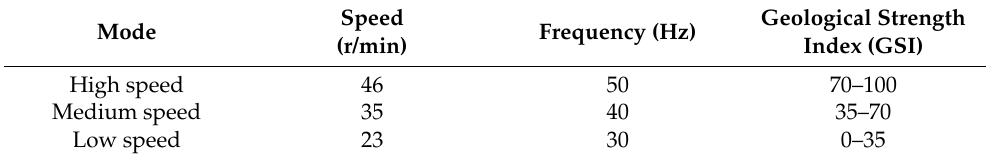
Figure 9. Fractal dimension and path planning. The cutting head swings along the planned path. The cutting head passes through different grids, and the speed of the cutting head is adjusted according to the geological strength index GSI value in the grid. The speed mode of the cutting head of the roadheader is divided into three modes: high speed, medium speed, and low speed. The speed mode of the cutting head can be switched by adjusting the frequency of the frequency converter of the roadheader, so as to realize the automatic speed regulation of the cutting head of the roadheader. The geological strength index is in the range of 0–35, and the speed of cutting head is low. The geological strength index is in the range of 35–70, the cutting head speed is medium, and the geological strength index is in the range of 70–100, the cutting head speed is high, as shown in Table 5. Table 5. Speed regulation mode of cutting